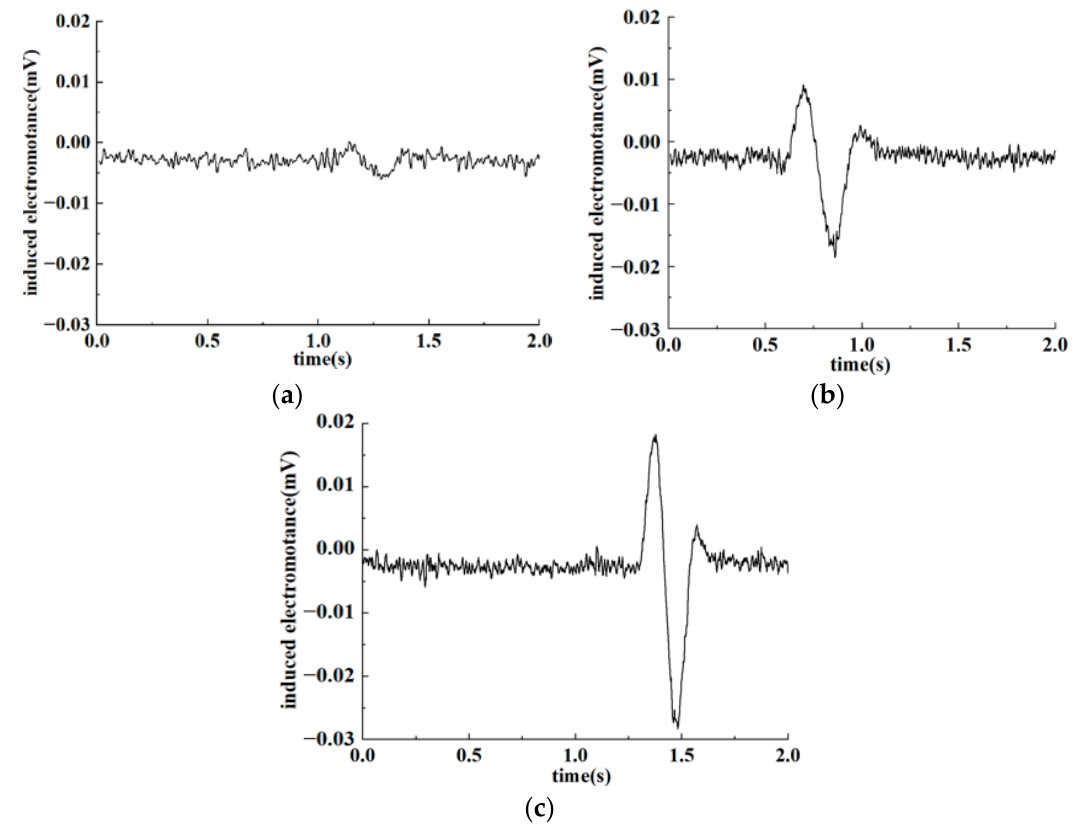
Figure 12. Detection results of non-ferromagnetic particles. ( a )3 20.74 μm; ( b ) 458.72 μm; ( c ) 550.04 μm.